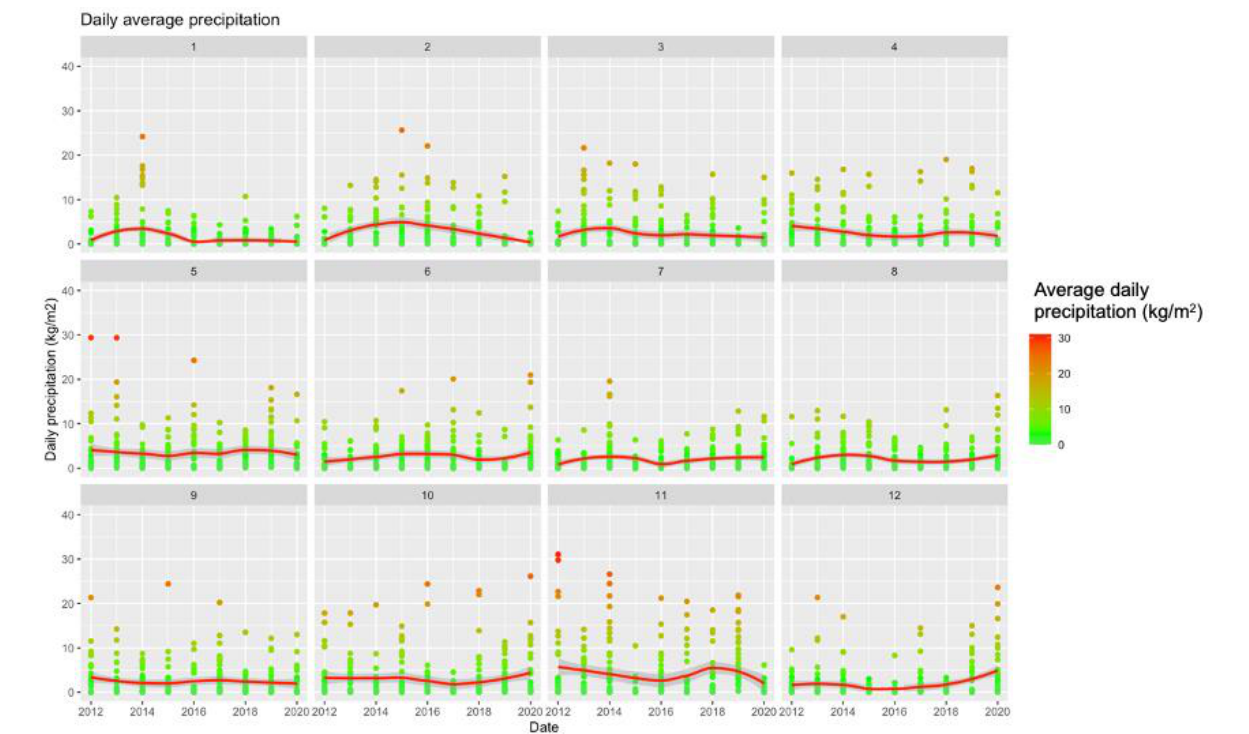
Figure A1. Summary of Meteorologic Data ( 2012 – 2020 ) Broken down by Calendar Month.